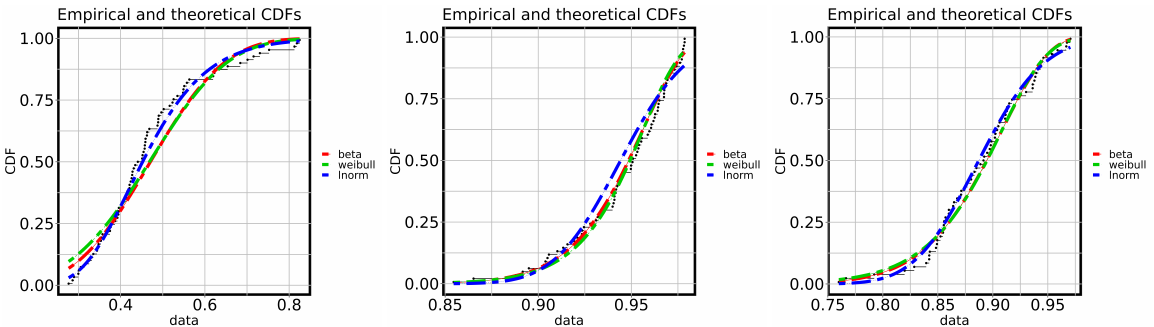
Figure 6. Cumulative PDFs of fitness versus theoretical density functions, after 36 epochs of training. The plot uses the same color and sensor convention as Figure